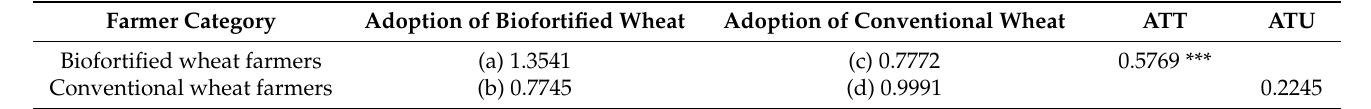
Table 5. The average treatment effects of the adoption of wheat biofortification on ROI.